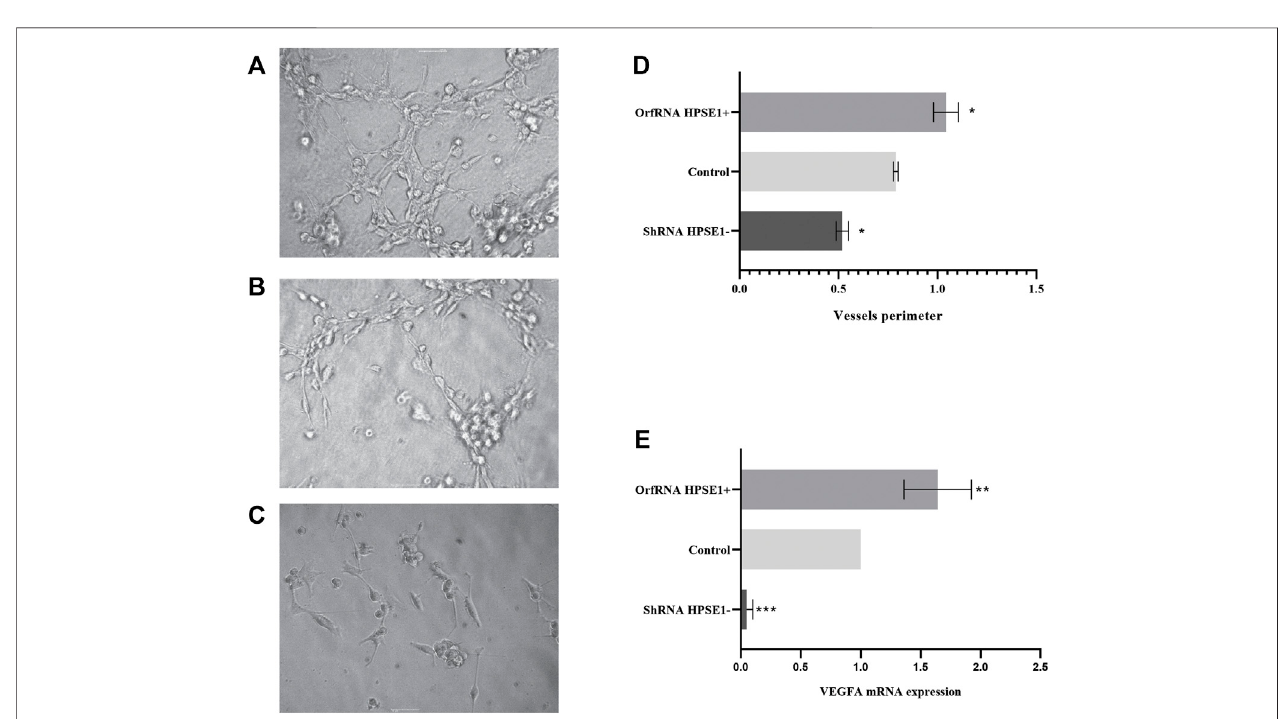
FIGURE 6 | Overexpression of HPSE1 enhances tumor neo-vascularization and induces VEGFA expression. HUVEC cells on a Miogel 2D layer co-culture. PhotomicrographofHUVECendothelialcellsadded withpreconditionedmediumfromOSCCcelllinesandtheir respectiveclonesafter12 hofexperiment: (A) HUVECcells incubatedwithpreconditionedmediumofSCC9-OrfRNAHPSE1+cloneoverexpressingHPSE1(100×); (B) HUVECcellsincubatedwithpreconditionedmediumofparental SCC9 (Control) (100×); (C) HUVEC cells incubated with preconditioned medium of SCC9-ShRNA HPSE1- clone with reduction of HPSE1 expression (100×). (D) Quanti fi cationofmeasuresofthevesselcircumferenceperimeterforeachoneoftheconditions;thegraphcompilestwoexperimentaltriplicateanalysis. (E) Geneexpression analysis of endothelial growth factor VEGFA by qRT-PCR; the graph compiles folded expression values of relative quanti fi cation by ddCT obtained through comparison of clonesOrfRNA HPSE1+ and ShRNA HPSE1 − relative tothe control SCC9 cells (normal reference = 1). Normalization of the analysis was performed using the endogenous control gene, PPIA. Statistical tests were performed using ANOVA followed by Tukey ’ s test, where * p < 0.05, ** p < 0.01, *** p < 0.001, and **** p < 0.0001.